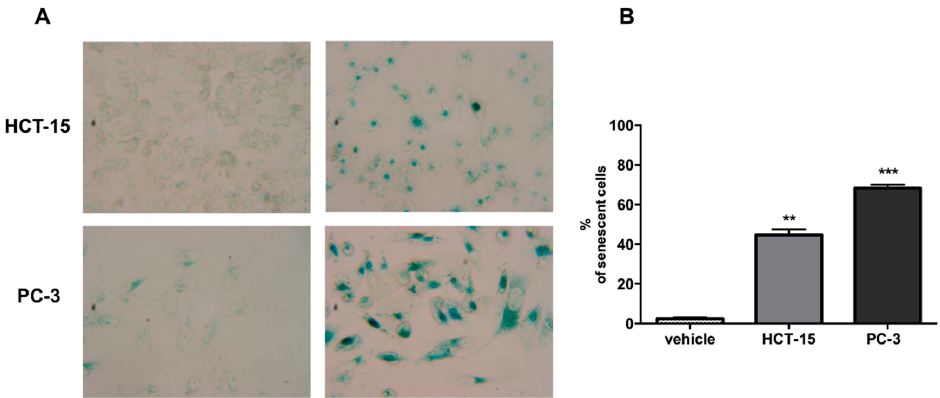
Figure 4. Argentatin B induces cell senescence at 72 h. ( A ) Representative micrographs of HCT-15 and PC-3 treated with argentatin B or vehicle (Magnification, ×40); ( B ) SA- β -gal-positive cells were evaluated by counting more than 100 cells for each treatment. Values presented are the mean of three independent experiments. Error bars indicate the standard error of the mean. ** p < 0.001, and *** p < 0.0001 vs. vehicle (one-way ANOVA test, and Tukey-Kramer post-test) Molecules 2015 , 20 , page–page It is known that the main characteristic of senescent cells is the inhibition of proliferation. PCNA